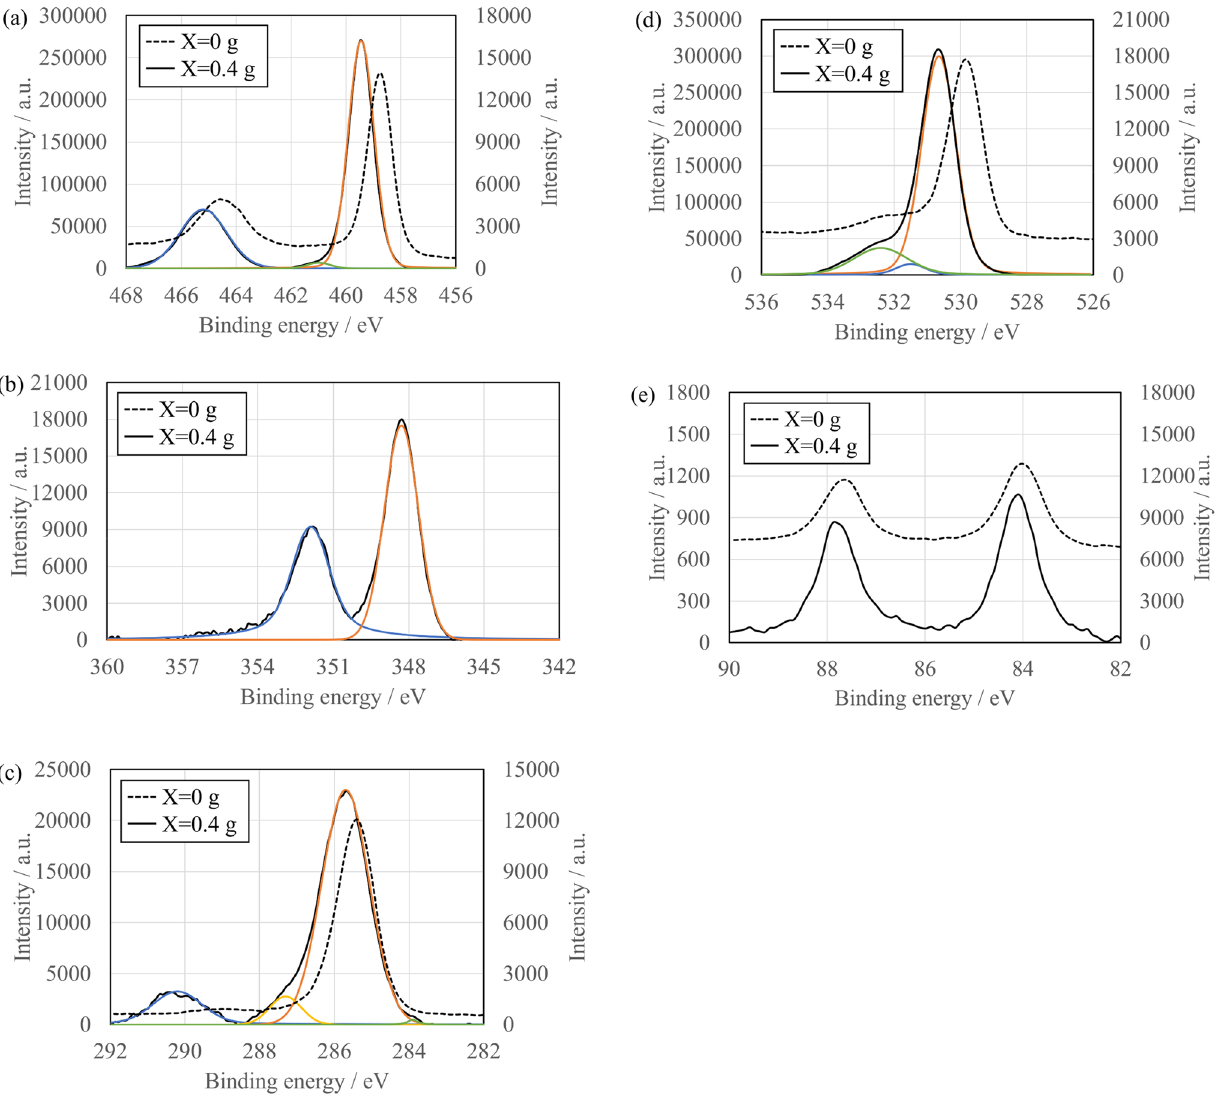
Fig. 12 X-ray photoelectron spectroscopy spectra for the AuNP/TiO 1s; d O 1s; e Au